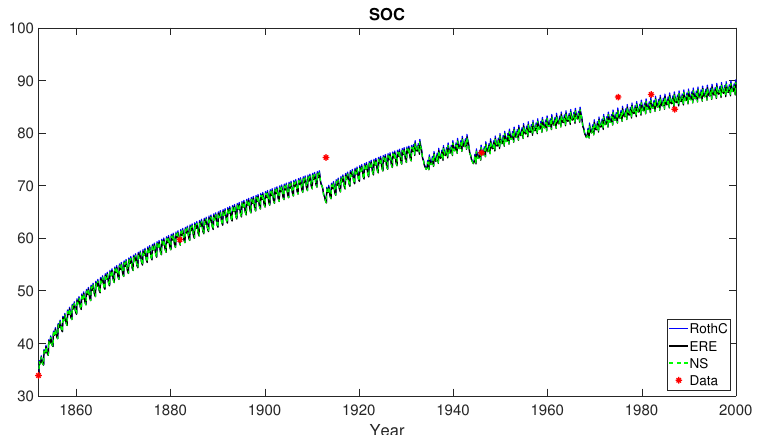
Figure 10. Hoosfield barley experiment. Scenario 2: farmyard manure annually. Organic C in soil data (red bullets) modelled by the RothC (8), ERE (13) and NS (17) methods in the temporal horizon [ 1852, 2000 ] with ∆ t = 1. According to Table 3, RothC approximation shows the best performance with respect to both the statistical indicators RMSE and EF.